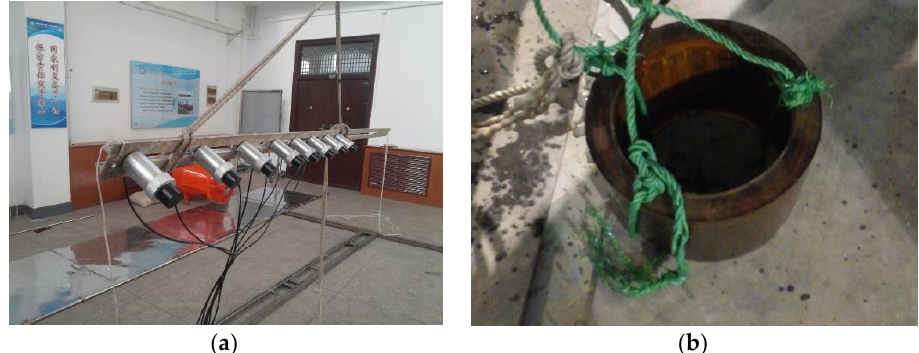
Figure 8. ( a ) The hydrophone array ( b ) The underwater acoustic transducer.